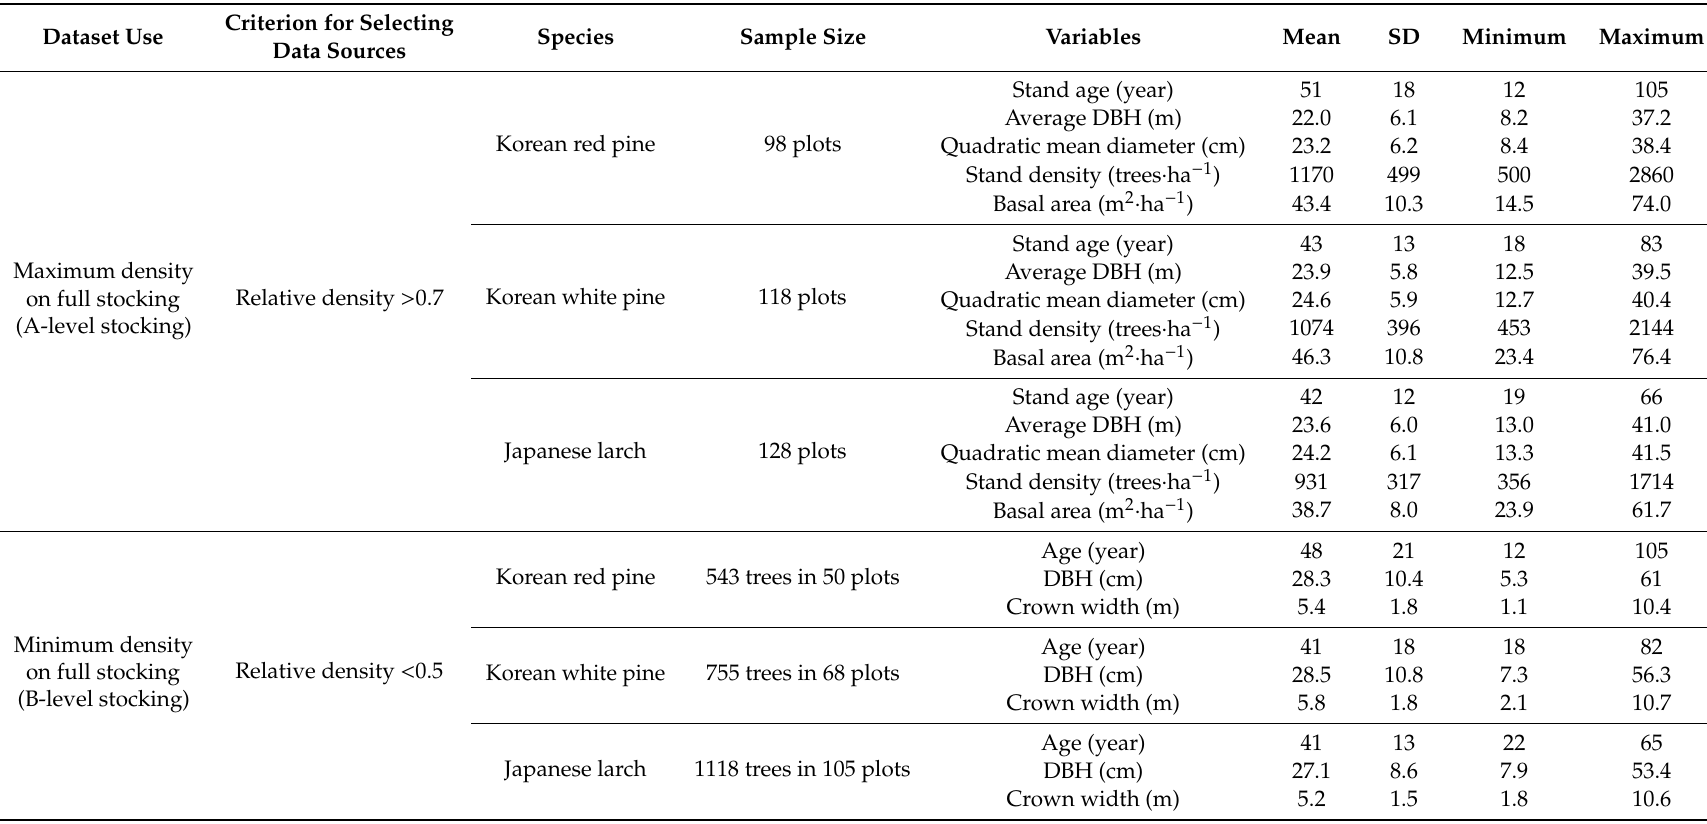
Table 1. Summary statistics of each sample data used for A-level and B-level stocking by species. DBH (The diameter at breast height); SD (standard